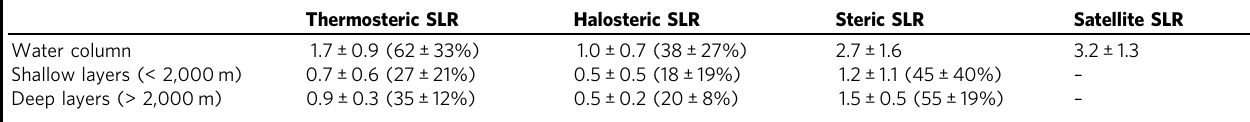
Thermo- and halosteric SLR are listed separately for the deep and shallow layers (below and above 2000m, respectively). Error indicates the 95% con fi dence interval, and the values in parentheses indicate the contribution to the total present steric SLR. The rate of SLR is given in mmy − 1